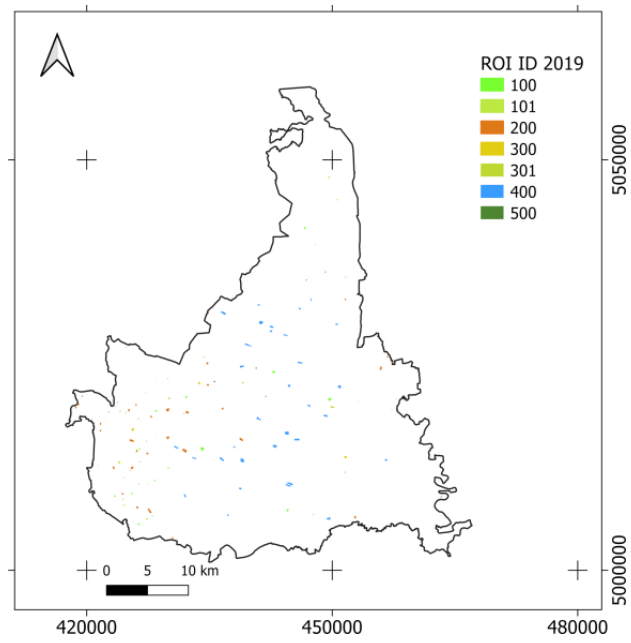
Figure 5. Regions of interest (ROI) distribution, code meaning is reported in Table 6 (Reference system is WGS 84/UTM zone 32N, EPSG: 32632). Table 6. Characteristics of ROI.